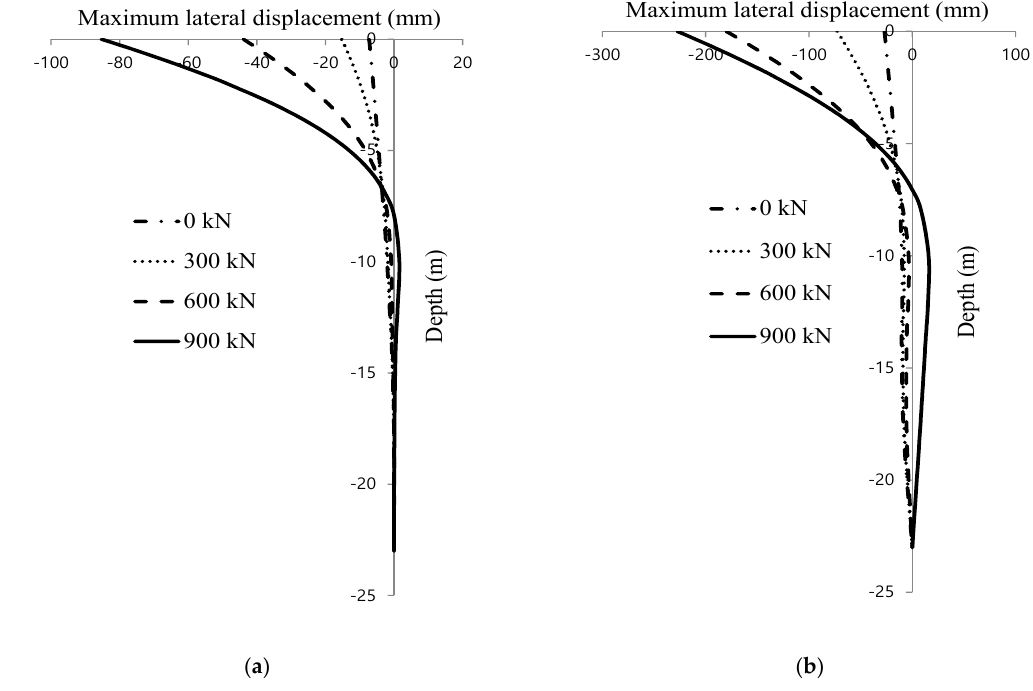
Figure 13. Maximum lateral pile displacement envelopes obtained from four different weight of superstucture. ( a ) Input acceleration: 0.13 g; ( b ) Input acceleration: 0.45 g.